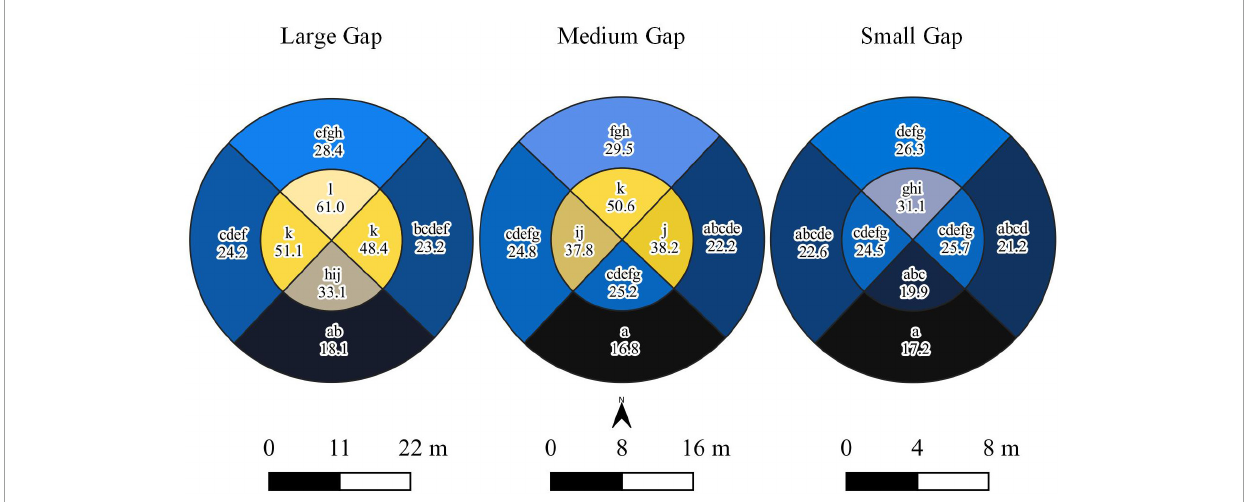
FIGURE2 Pairwise differences in percent seasonal direct solar radiance by gap size and section. Polygons of different colors and not connected by the same letters are significantly different at an α = 0.05.